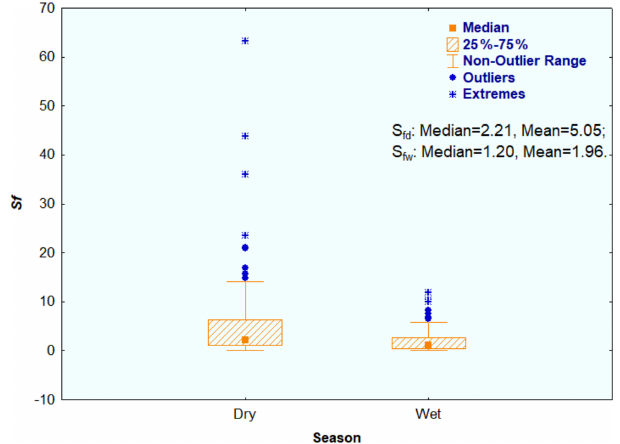
Figure 2. A comparison of ecohydrological sensitivity in the dry season and wet season ( S f d and S f w show dry season ecohydro- logical sensitivity and wet season ecohydrological